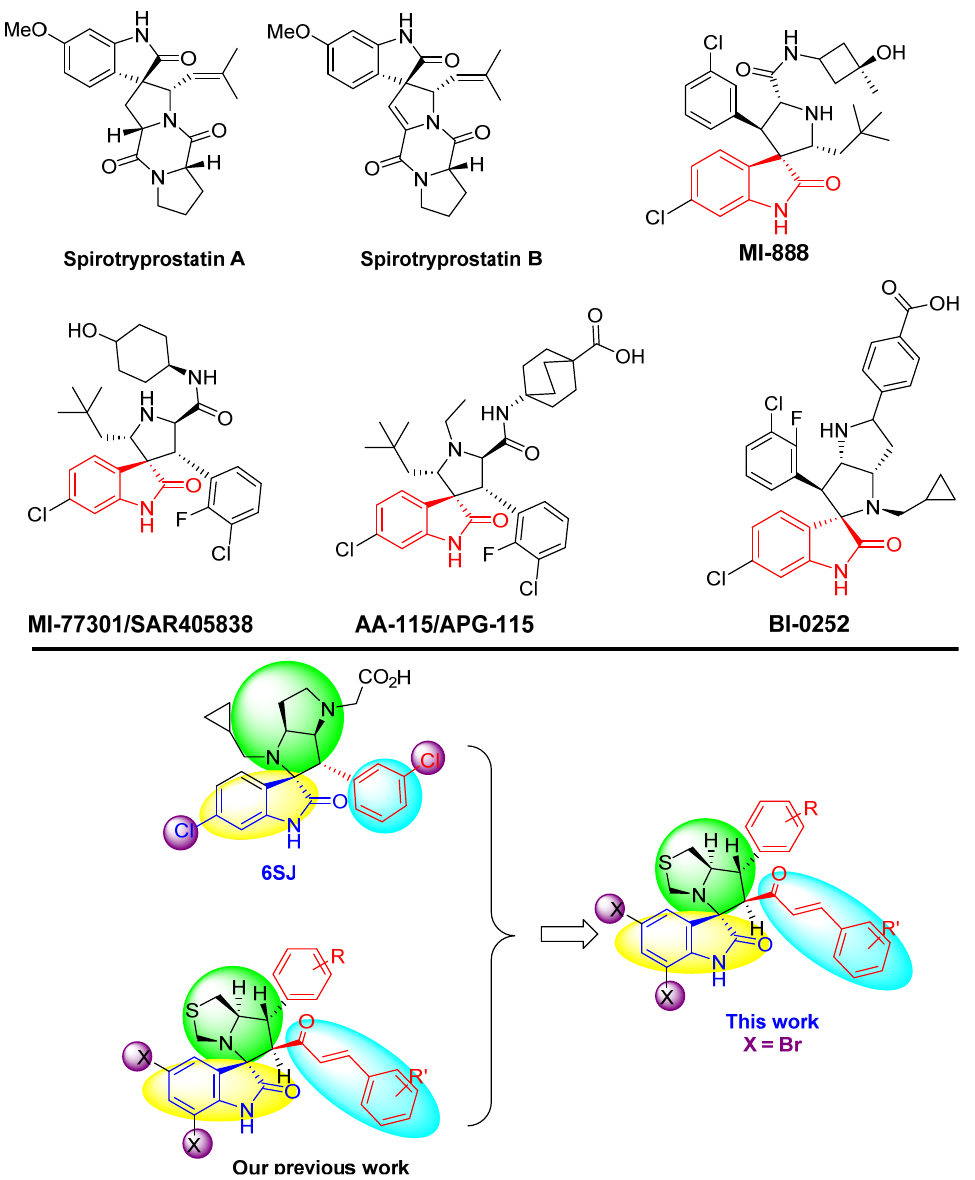
Figure 1. Natural (Spirotryprostatin A and B) and other synthetic spirooxindole scaffolds with high biological importance and structure-activity relationship.